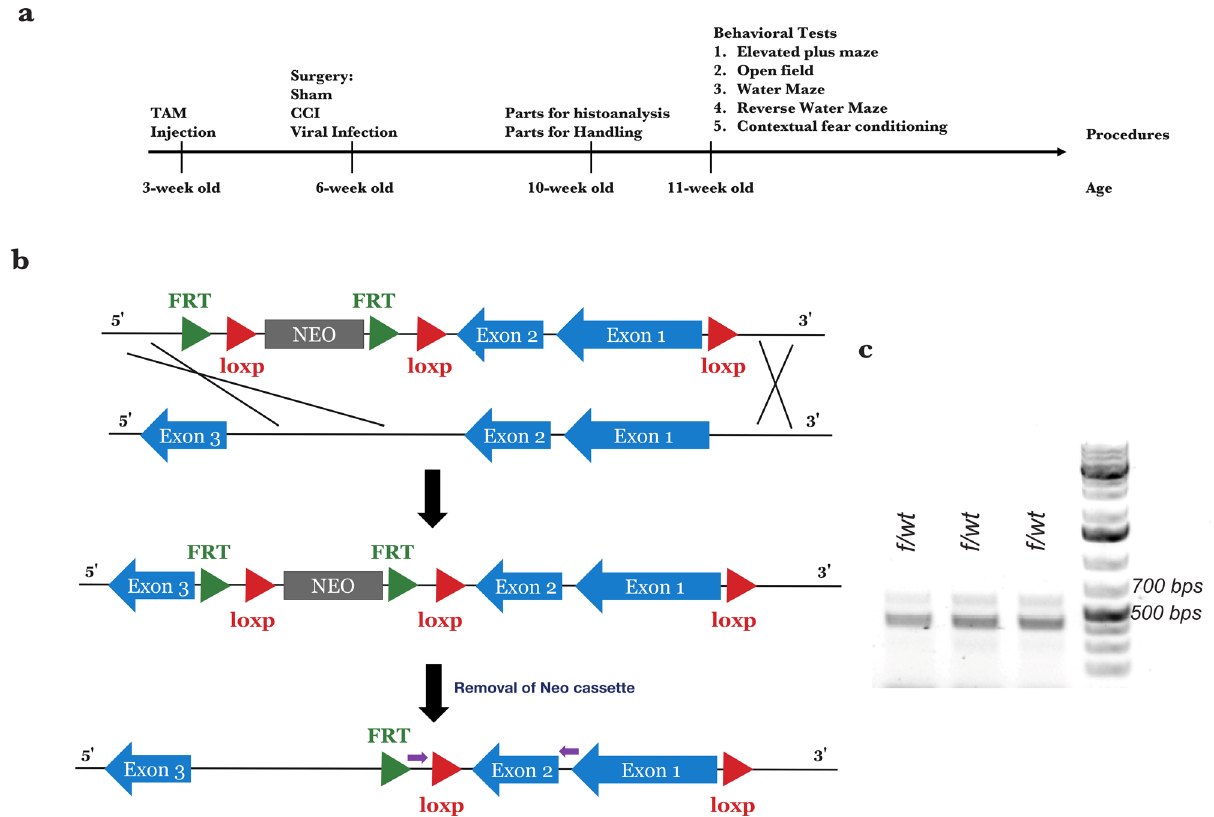
Fig. 1 Overview of the generation of ApoE-conditional knockout animals and experimental outline. a To generate ApoE-conditional knockout mice, exon 1 and exon 2 of the ApoE gene were fl anked with loxp sites to allow for cre-dependent recombination. The primers for genotyping were designed to fl ank exon 2 of the ApoE gene with or without one of the loxp sites. b Timeline of experiments. Mice received tamoxifen at three weeks of age. At six weeks of age, sham or CCI surgery was performed. A subset of mice received eGFP-expressing retrovirus targeted to the dentate gyrus at the conclusion of surgery. Four weeks after viral infection, mice were perfused to analyze the morphology of newborn neurons or stained using Golgi – Cox method. Habituation was performed on the remaining mice. Following habituation, the elevated plus maze, open fi eld, Morris water maze, and contextual fear-conditioning tasks were performed. c The 500 bp DNA fragment generated by PCR indicates mice without the loxp- fl anked ApoE, the 750 bp result indicates mice with two copies of loxp- fl anked ApoE, and the hemizygous mice generate one 500-bp and one 750-bp